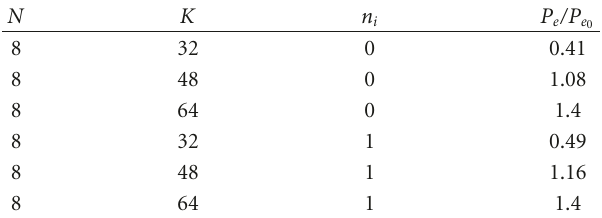
Table 7: The ratio P e /P e of the automatic detector for μ = 1, ν = 0 = 0 . 025 in homogeneous and nonhomogeneous clutter. 0 . 5, and P e 0